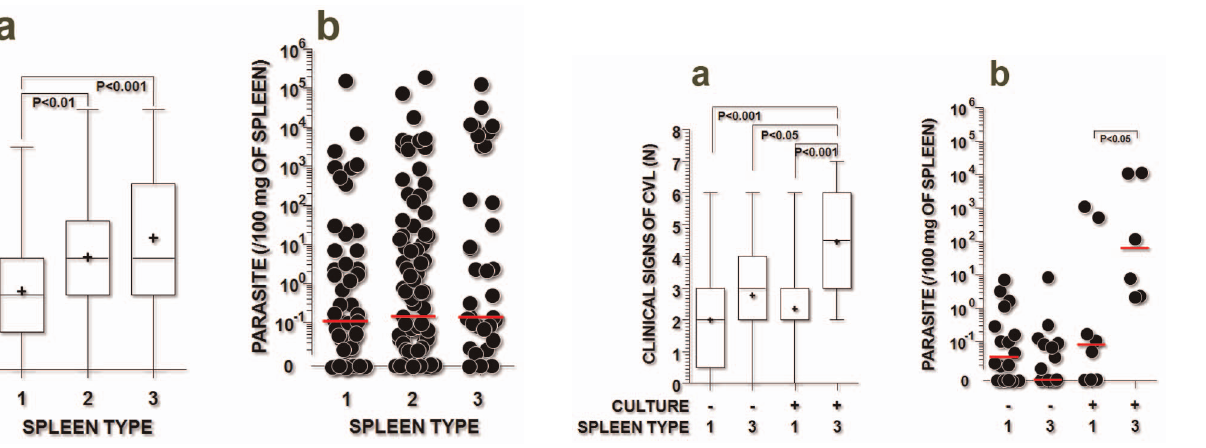
Chi-square test for trends: a P , 0.05,